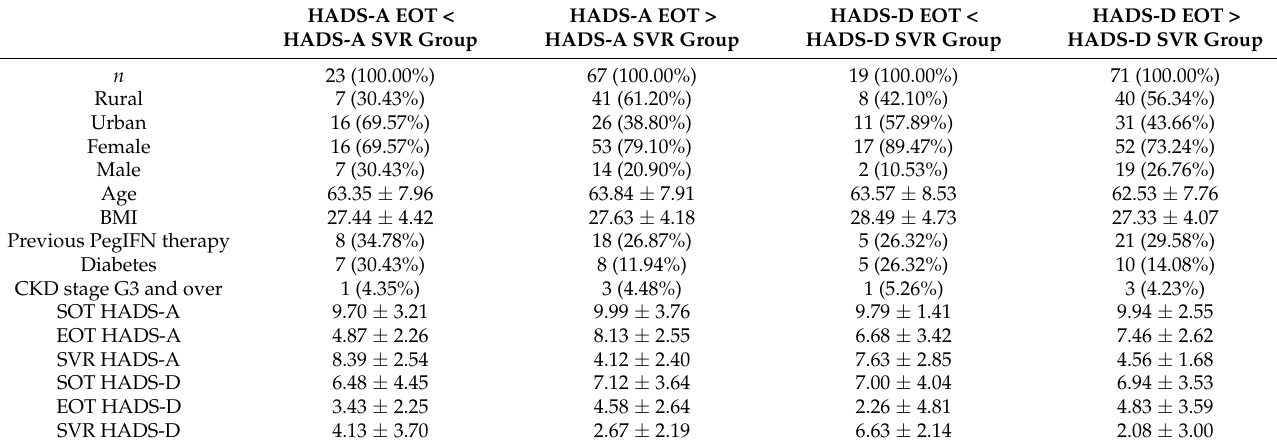
Table 5. Differences between patients’ groups who had rebound HADS scores at SVR compared to EOT.